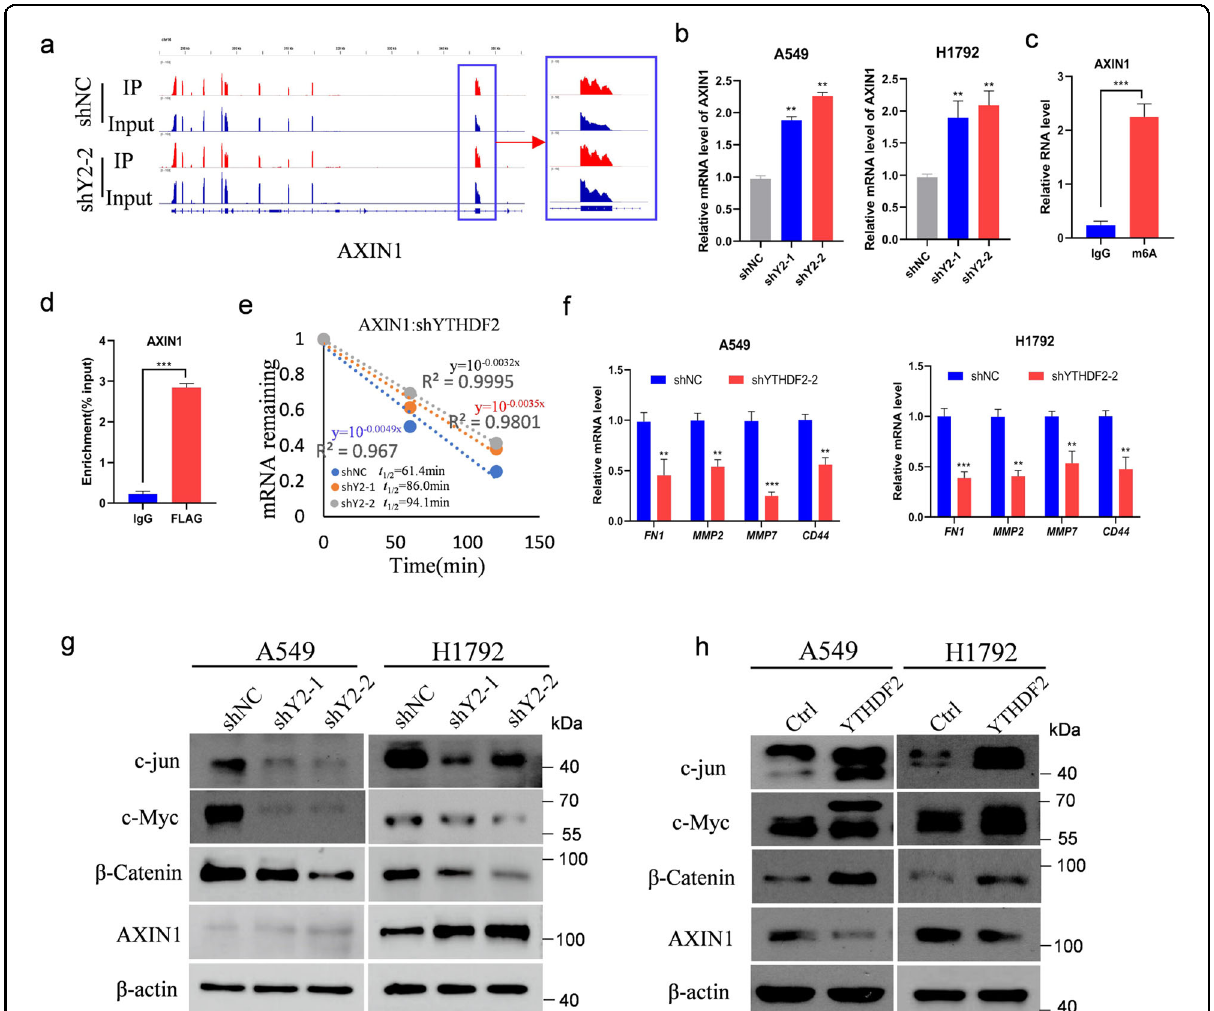
Fig. 5 AXIN1/Wnt/ β -catenin signaling was targeted by YTHDF2. a Distribution of m6A peaks across AXIN1 transcripts in control and YTHDF2- de fi cient cells. b qPCR analysis of AXIN1 mRNA expression in A549 and H1792 with or without YTHDF2 knockdown. Samples were normalized to β -actin mRNA. c Enrichment of m6A modi fi cation in AXIN1 as detected by a gene-speci fi c m6A qPCR assay. d RIP – qPCR showing the association of AXIN1 with FLAG-tagged YTHDF2 in A549 cells. e Increased AXIN1 mRNA half-life by silencing YTHDF2 in A549 cells. Values were the mean ± S.D. of n = 3 independent experiments. f Relative mRNA levels of AXIN1/Wnt/ β -catenin downstream targets identi fi ed by qPCR analysis in A549 and H1792 cells. Data represented means ± S.D. for three independent experiments. Immunoblotting to measure c-jun, c-Myc, β -catenin, and AXIN1 protein levels in transformed A549 and H1792 control cells and cells with YTHDF2 knockdown ( g ) or YTHDF2 overexpression ( h